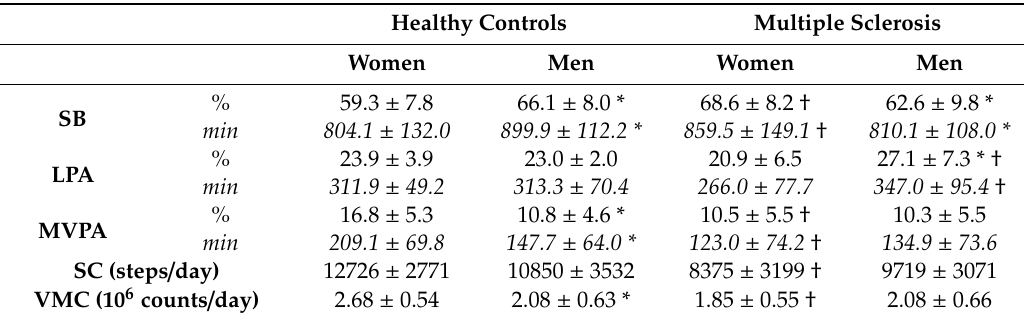
Table 3. Physical activity patterns for men and women with Multiple Sclerosis and those unaffected. Values are expressed as mean ± SD.